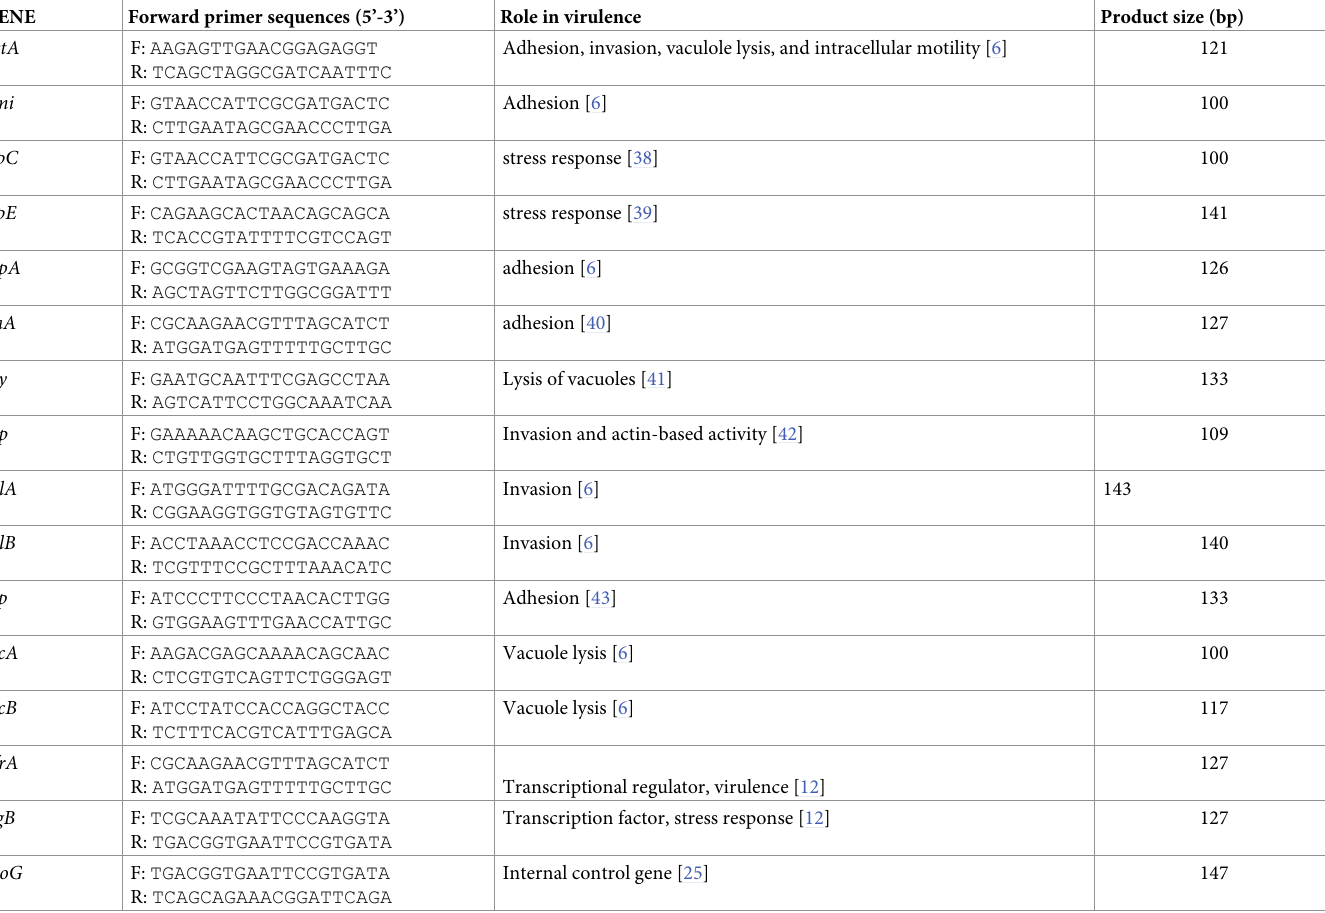
Table 2. Oligonucleotides used for real-time PCR to evaluate the virulence and stress related genes in L . monocytogenes . GENE Forward primer sequences